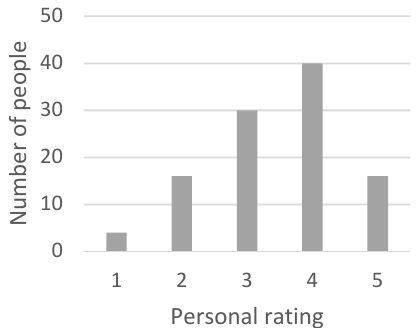
Figure A4. Previous experience with recycling, first survey (106 individuals).